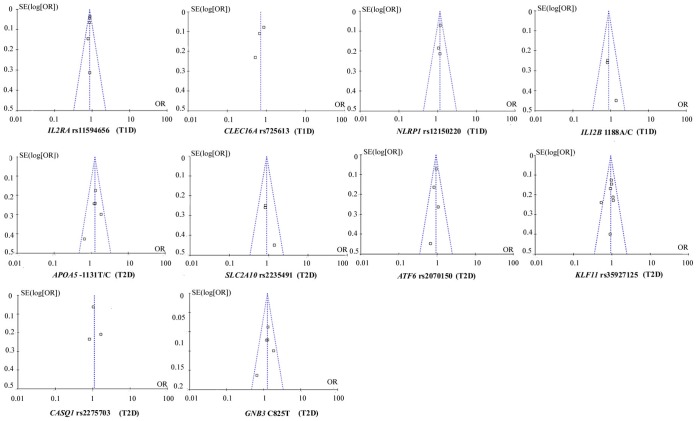
Funnel plots of the studies involved in the 10 meta-analyses.